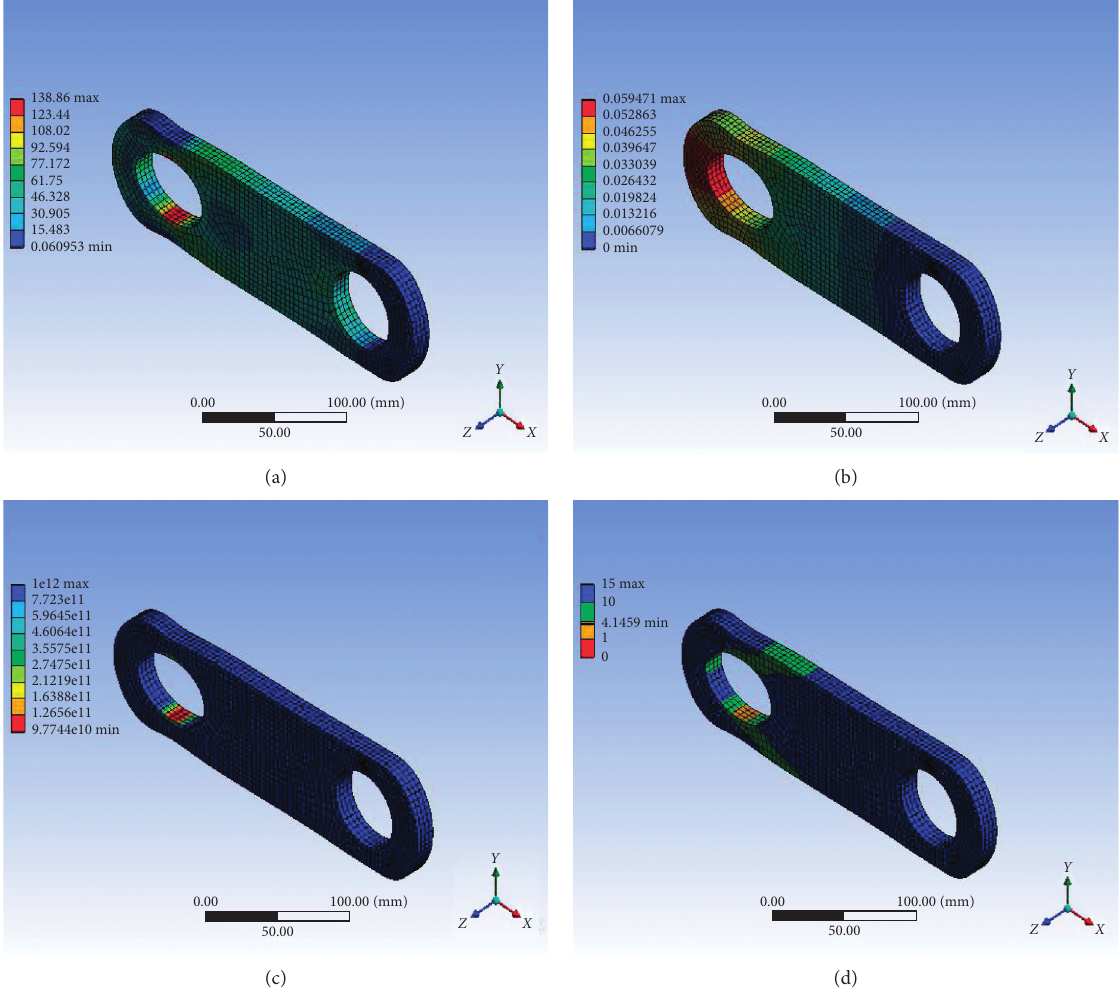
Figure 14: Simulation results for chain link with a modeled crack and neck radius 500mm ( X � 1mm): (a) equivalent stress, (b) deformation, (c) fatigue life, and (d) safety